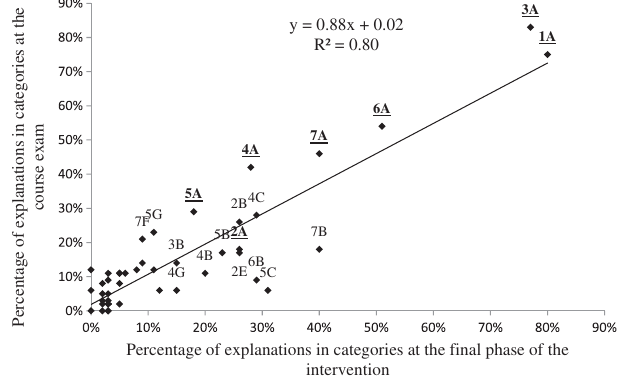
FIG. 1. The percentages of the students’ categorized responses in the course exam versus the final phase of the intervention, N ¼ 65 . Data points supplemented with numbers 1–7 and A–E refer to the question numbers and conception categories pre- sented in Tables VII–XIII. The category symbols have been excluded from categories in the case of percentages below 15% in order to enhance the readability of the figure. The categories (1A–7A) referring to correct conceptions are pre- sented in boldface and